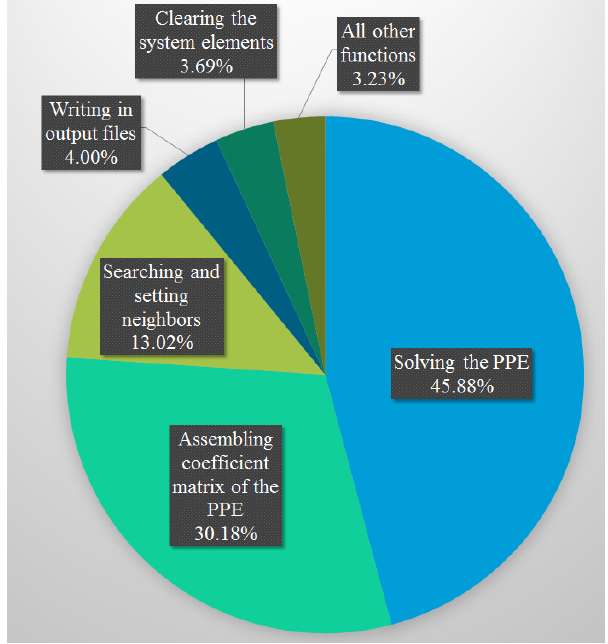
Fig. 10: Functions relative execution time in the